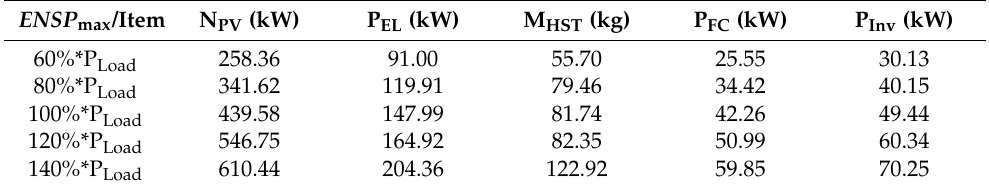
Table 12. Sizing results of an HPV/FC energy system using the IAEO and ENSP max = 5% considering load variations.